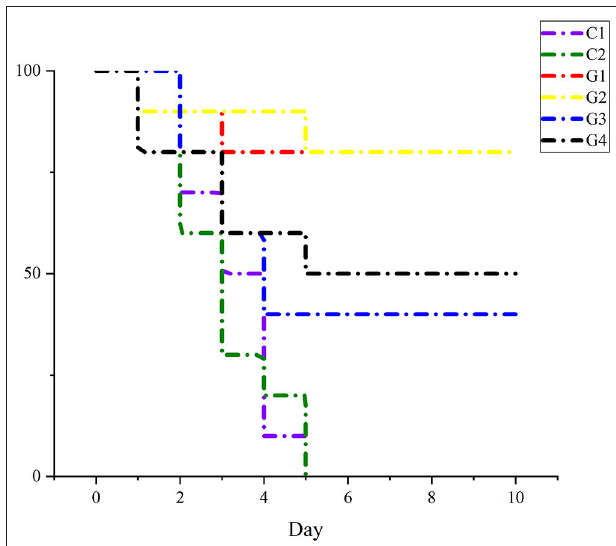
FIGURE 6 | The percent of survival rate of mice after being challenged with E. coli to each group.